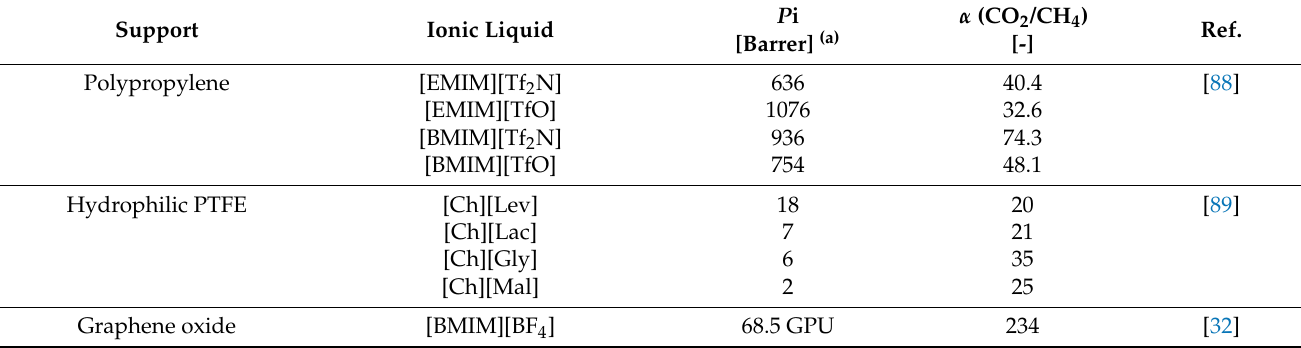
Table 2. Some recent data for supported ionic liquid membranes in CO 2 /CH 4 gas separations. Support Ionic